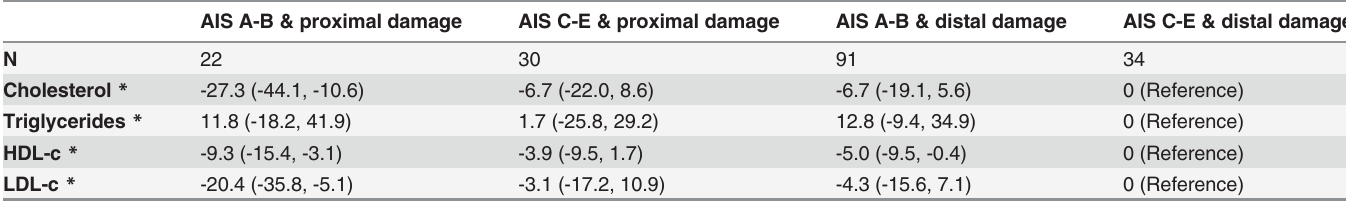
Table 4. Differences in serum lipids classi fi ed according to a combined classi fi cation of motor grade and neurological level of